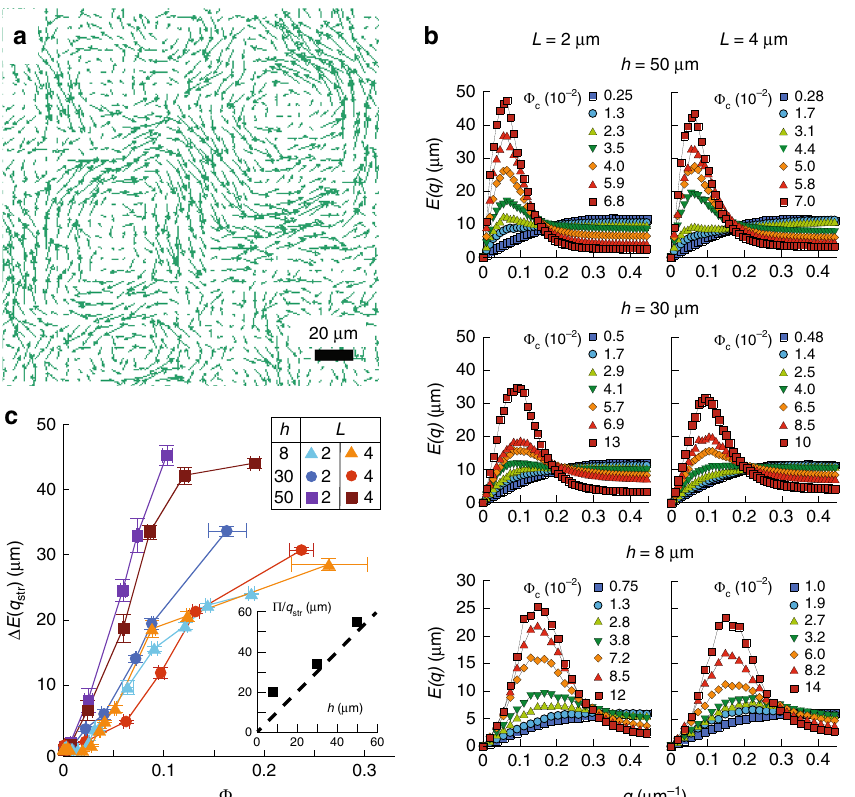
¼ 0 : 08, cell length c Þ as a function of cell density in the different experimental conditions. Each point is the str as a function of str quantify the local velocity fi eld v ð r Þ , averaged over several neighbouring bacteria (Fig. 2a). The spatial structure of the fl ow fi eld at varying cell volume fraction Φ was characterized by the c